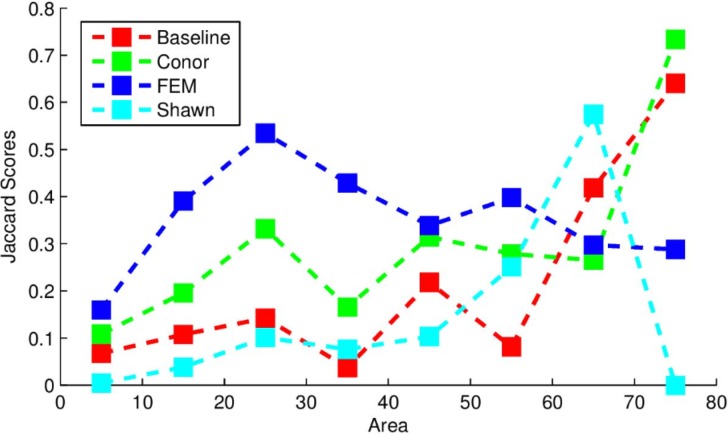
Jaccard scores for each participating team, evaluated across crown diameters.This figure was produced and provided by the competition organizers (Marconi et al., 2018).